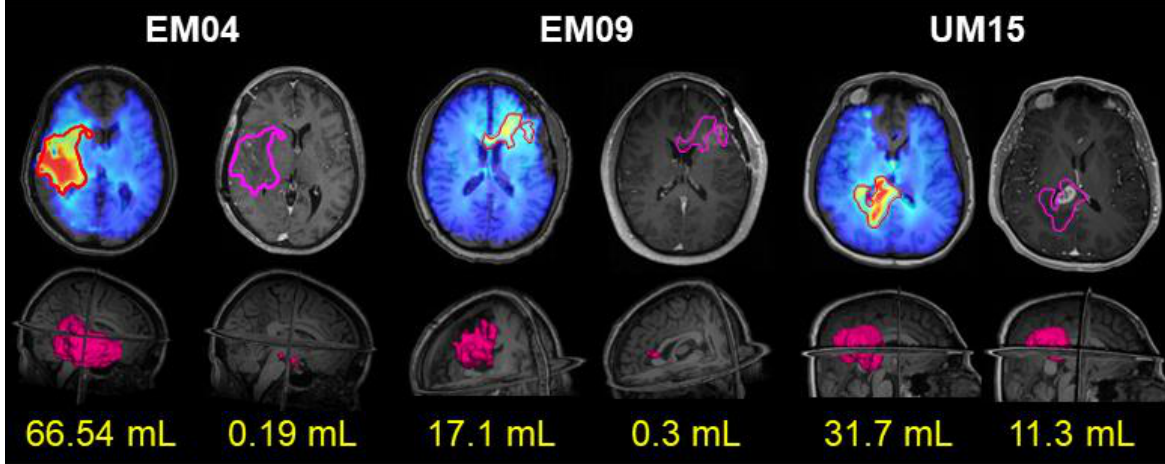
Figure 1. A comparison between the ratio map of choline to N-acetylaspartate (Cho/NAA) and T1-weighted contrast-enhanced (T1w-CE) imaging for three patients on the trial. For each patient, the top left image contains the Cho/NAA ratio map superimposed on the T1w image along with a contour encompassing all voxels with a Cho/NAA ≥ 2x normal. That contour is overlaid on the T1w-CE image on the top right image which shows enhancement from residual tumor and recent surgery. The bottom left image shows a 3D volume rendering of the volume of tissue that received 75 Gy of radiation guided by the Cho/NAA ≥ 2x contour, while the bottom right image shows a 3D volume rendering of the residual contrast enhancing lesion, which normally receives 60 Gy of radiation along with resection cavity in standard therapies. In all cases, the Cho/NAA ≥ 2x contour was significantly larger than the contrast-enhancing